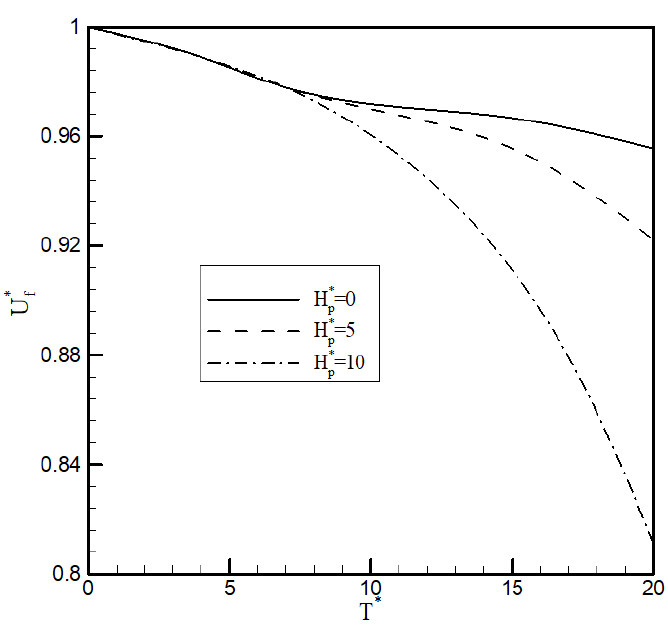
Figure 6. The effect of the tip propulsor thrust and angular momentum on the flutter speed of the wing (case 2).